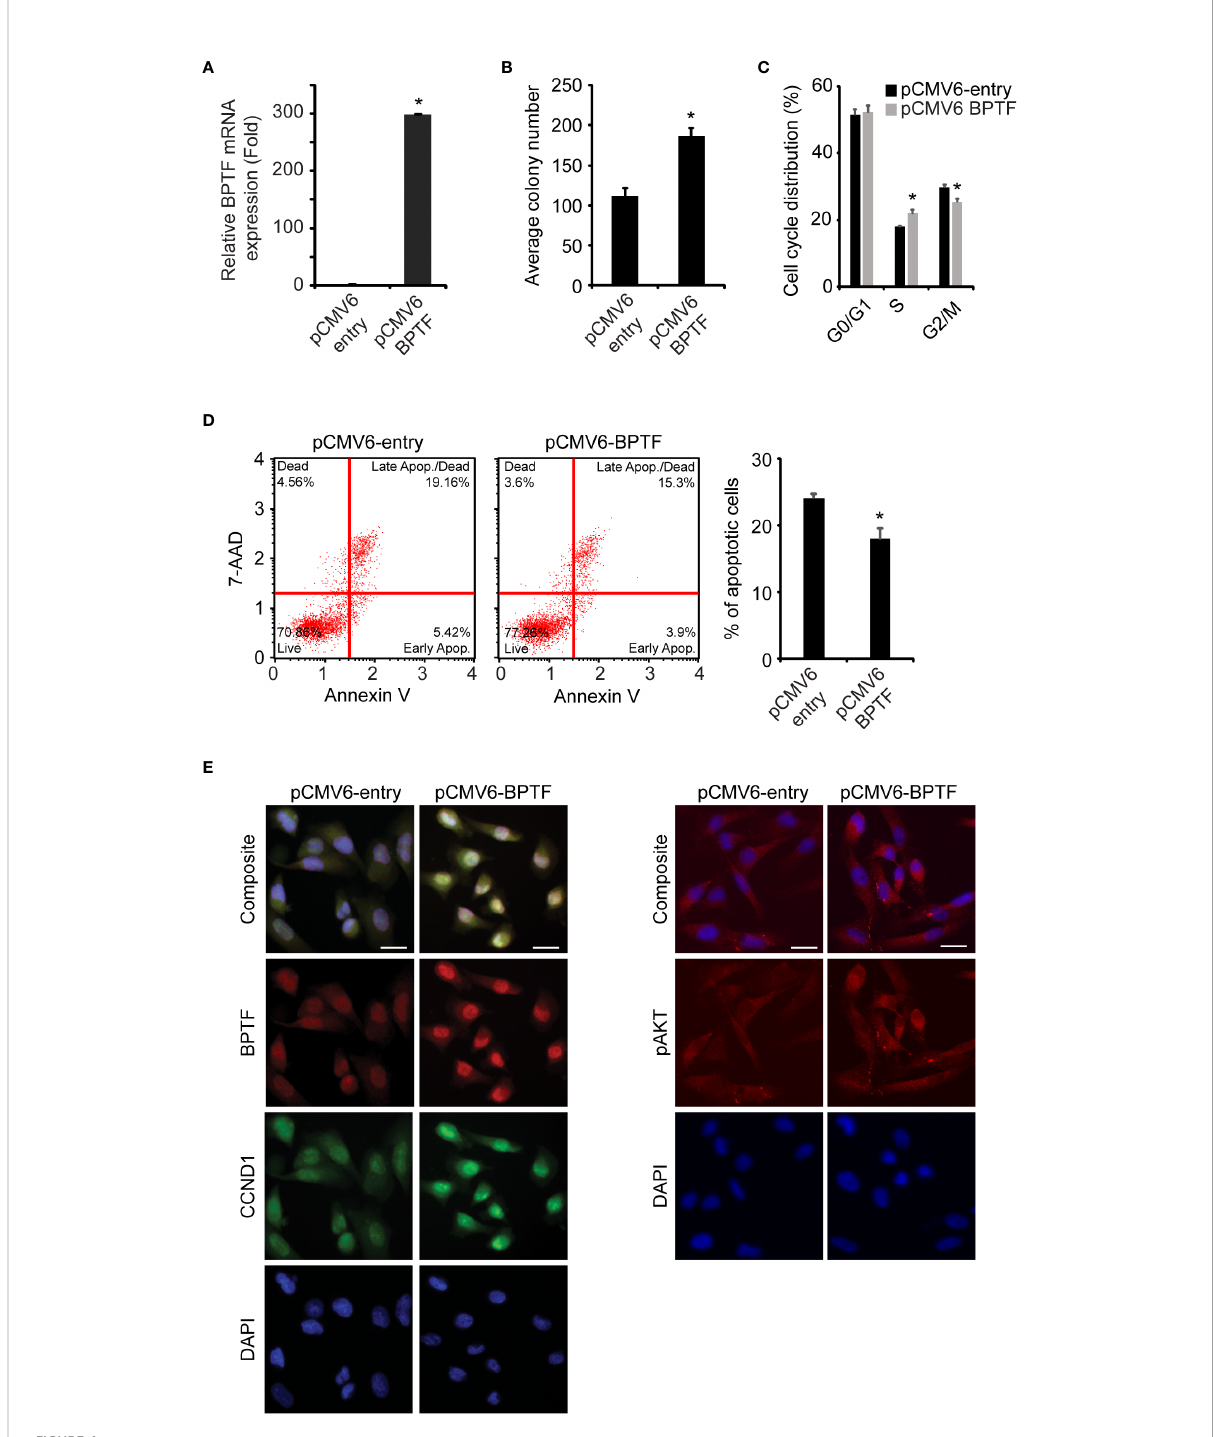
FIGURE 4 Effects of BPTF overexpression on MDA-MB-231 cells. (A) BPTF overexpression in MDA-MB-231 cells. (B) Colony formation assay following BPTF overexpression. (C) Cell cycle analysis following BPTF overexpression. (D) Analysis of apoptotic rate after BPTF overexpression based on detection of 7-AAD and Annexin V. (E) Quantitative immuno fl uorescence of various proteins following BPTF overexpression. Scale bar 20 m m. *p <